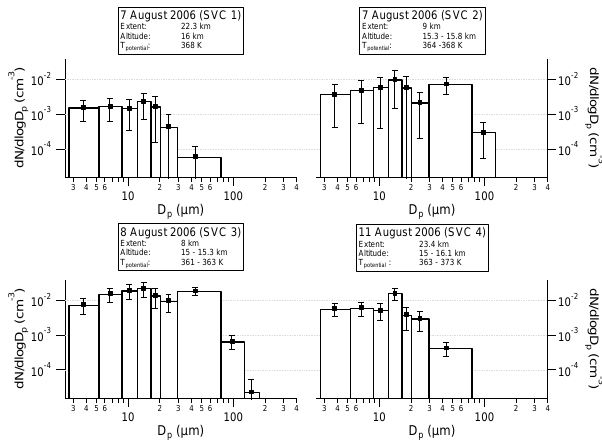
Fig. 16. Subvisual cirrus (SVC) ice particle size distributions (com- bined FSSP-100 and CIP in situ data) from 7, 8, and 11 August 2006 over West Africa. The horizontal extent was estimated from flight time intervals. The local cold point tropopause height was 16.3km on 7 August 2006 and 16.5km on the other days. The error bars result from uncertainties in the sampling volumes and counting